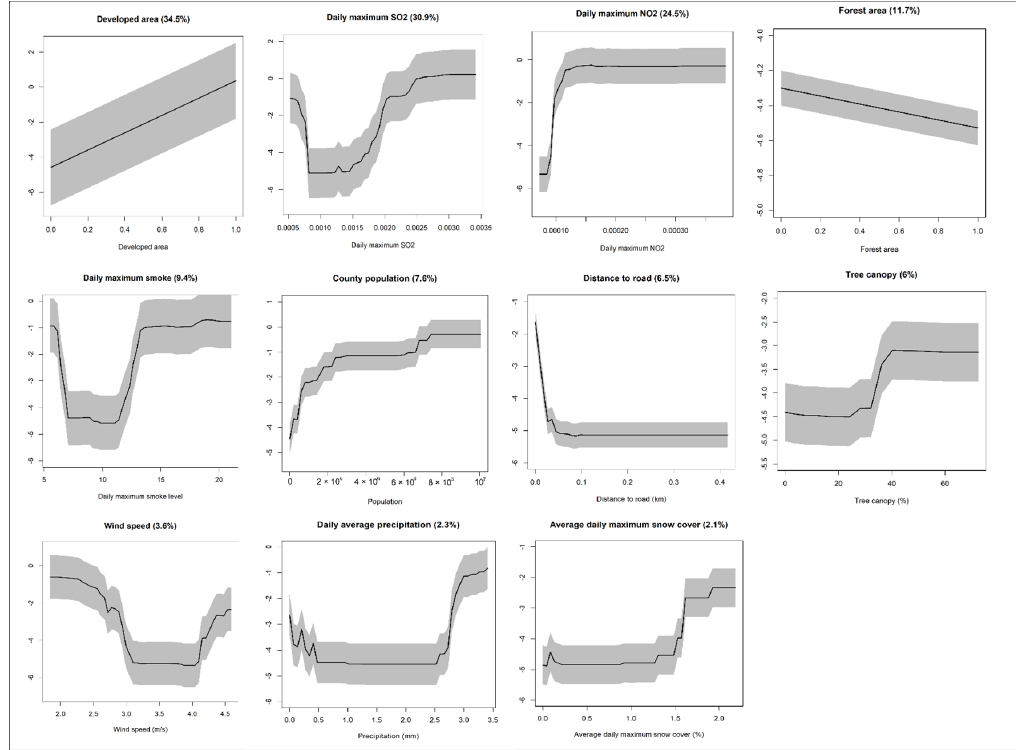
Figure 5. Partial dependency plots of covariates used in the RF model to estimate the spatial distribution of the mortality of the Barn Owl. The gray shading area indicates the confidence intervals derived from the model iterations. We report the mean decrease accuracy for each of the variables in the